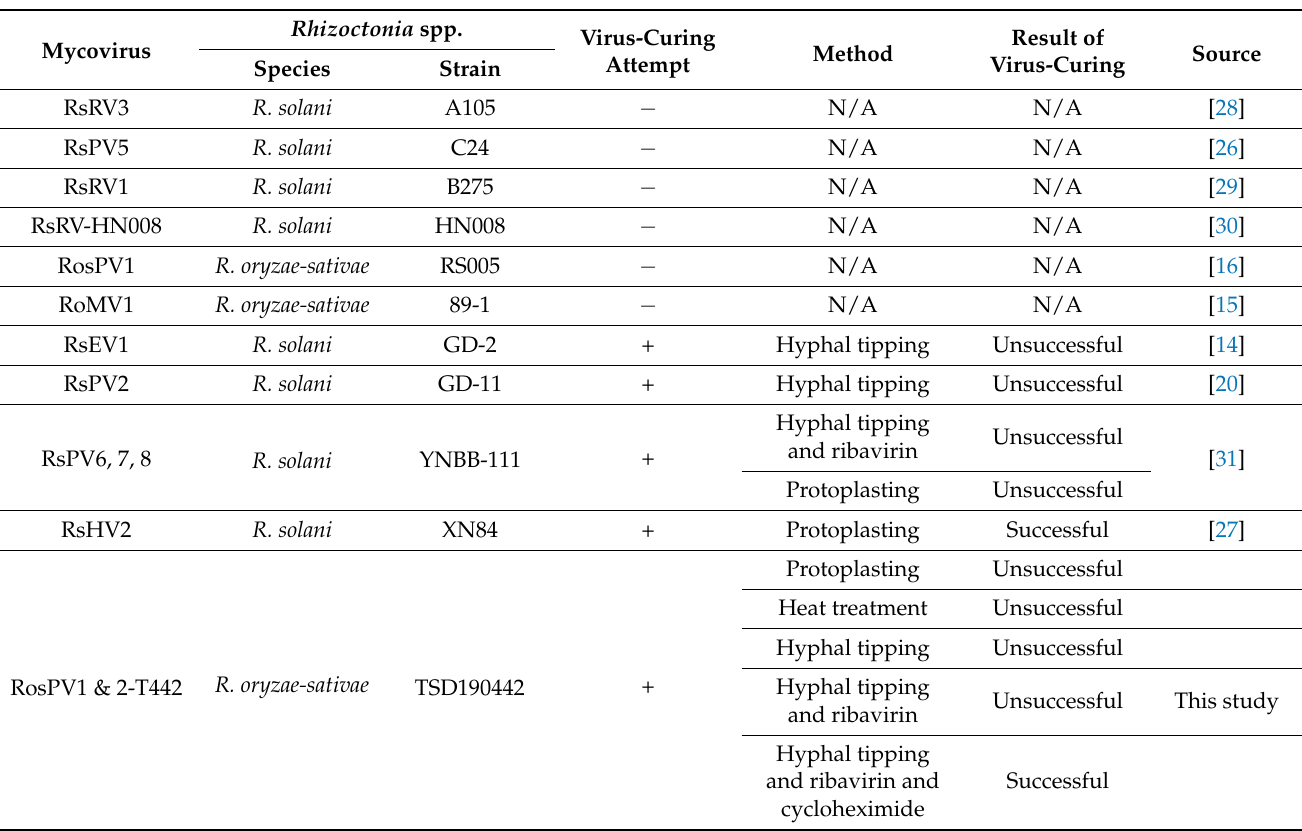
Table 3. An overview of mycovirus elimination in Rhizoctonia